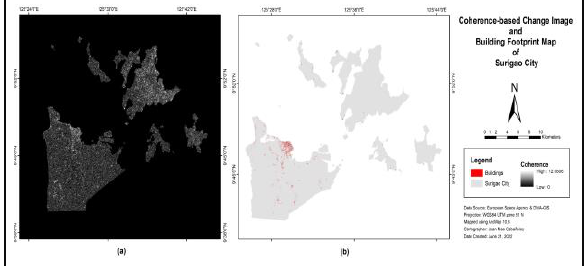
Figure 6 . Coherence-based change image and building footprint of Surigao City